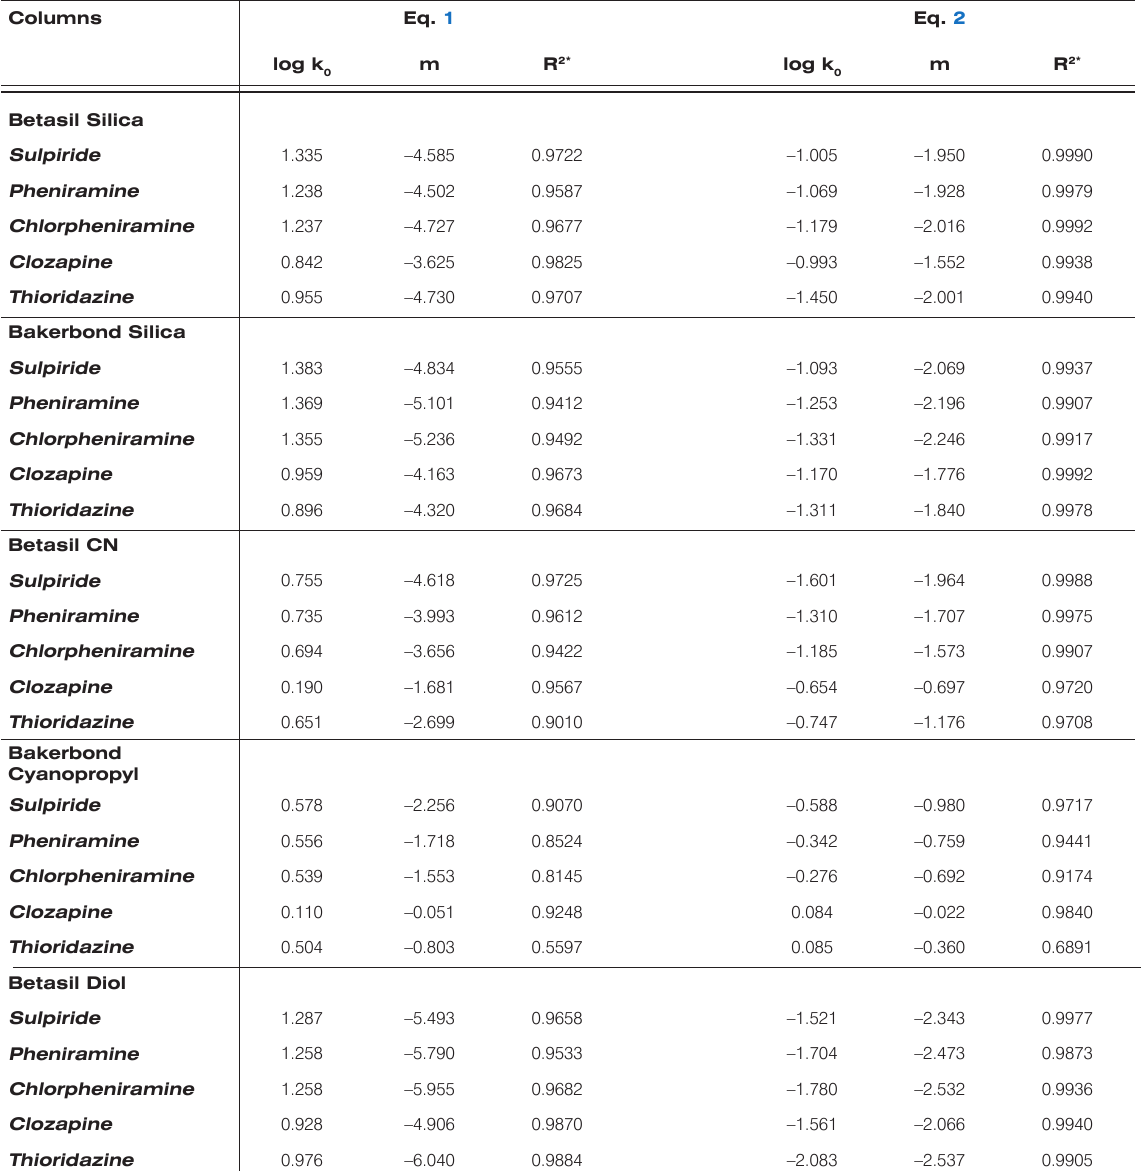
Table 1. The parameters log k and m of the analyzed substances obtained using Eq. 1 and Eq. 2 in HILIC region of the mobile phase contents 0 (10–30% of the aqueous